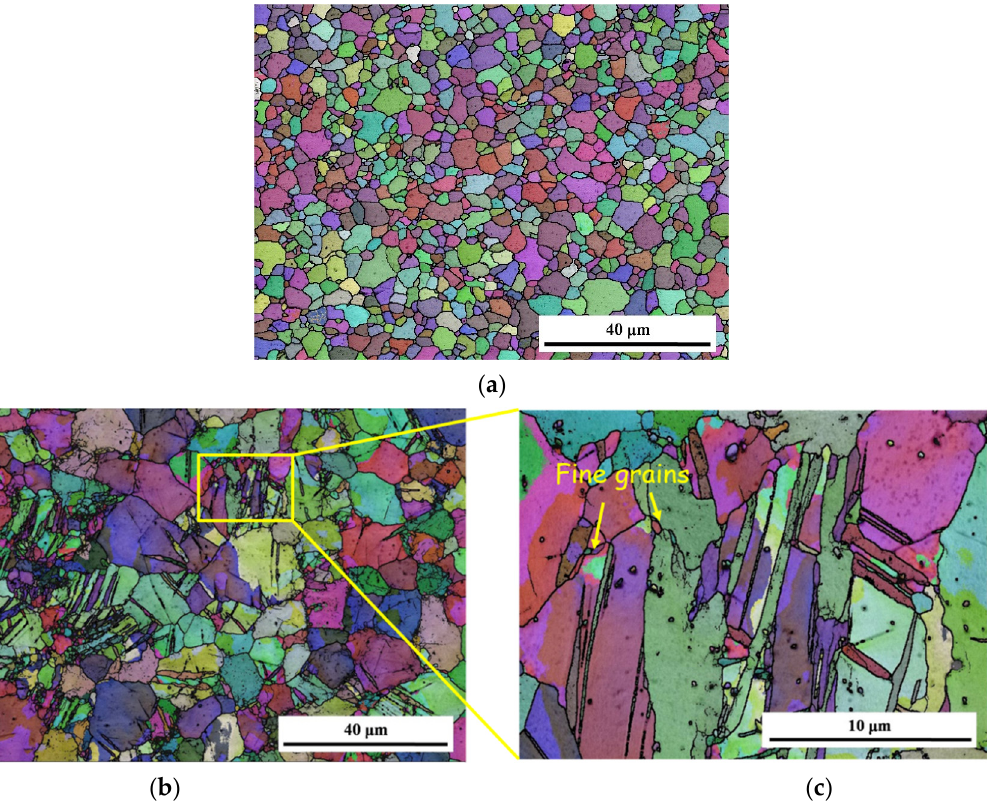
Figure 2. Schematic diagram of sample observation surface: ( a ) grain structure of original plates; ( b ) grain structure of reprocessed plates at low magnification; ( c ) grain structure of reprocessed plates at high magnification.